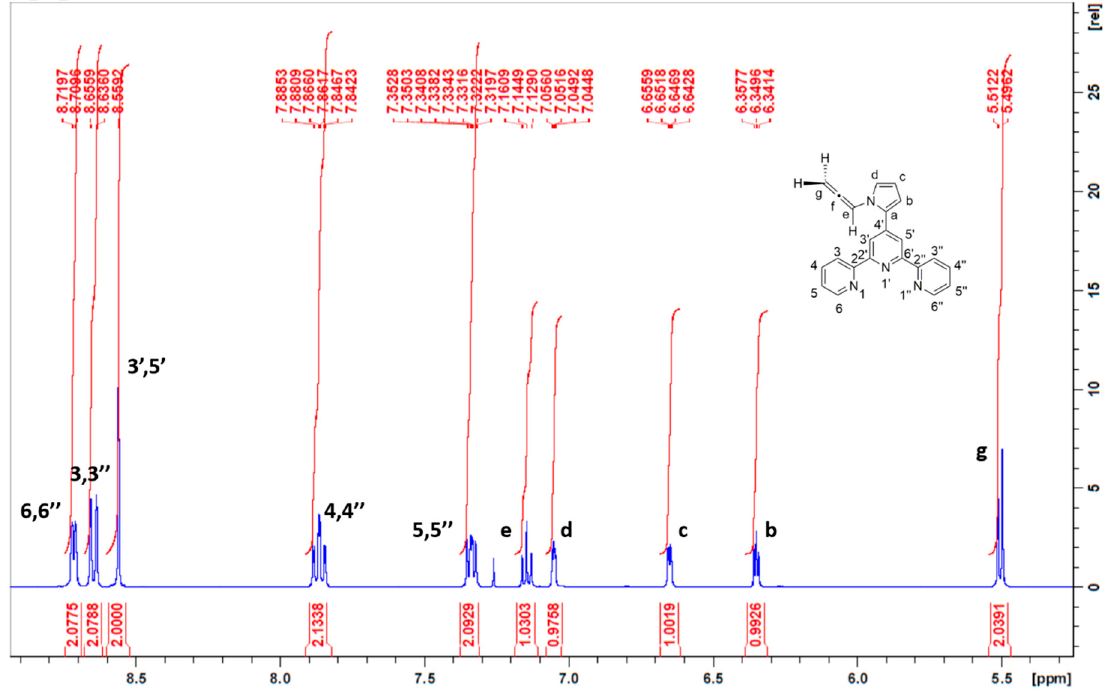
Figure 3. 1 H NMR spectra of compound 1 (inset: structure and atom numbering of 1 ) .